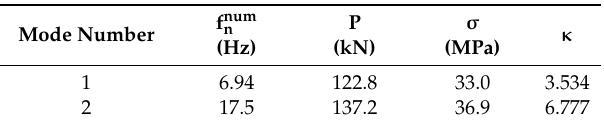
Table 5. The force values read for the first two mode shapes and the value of coefficient κ determined by the calculation of the updated model.